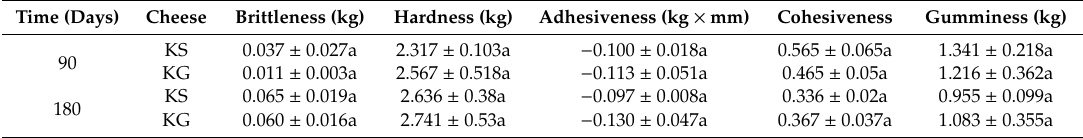
Table 5. Changes of textural characteristics of mature kashkaval of Pindos cheese made from 100%